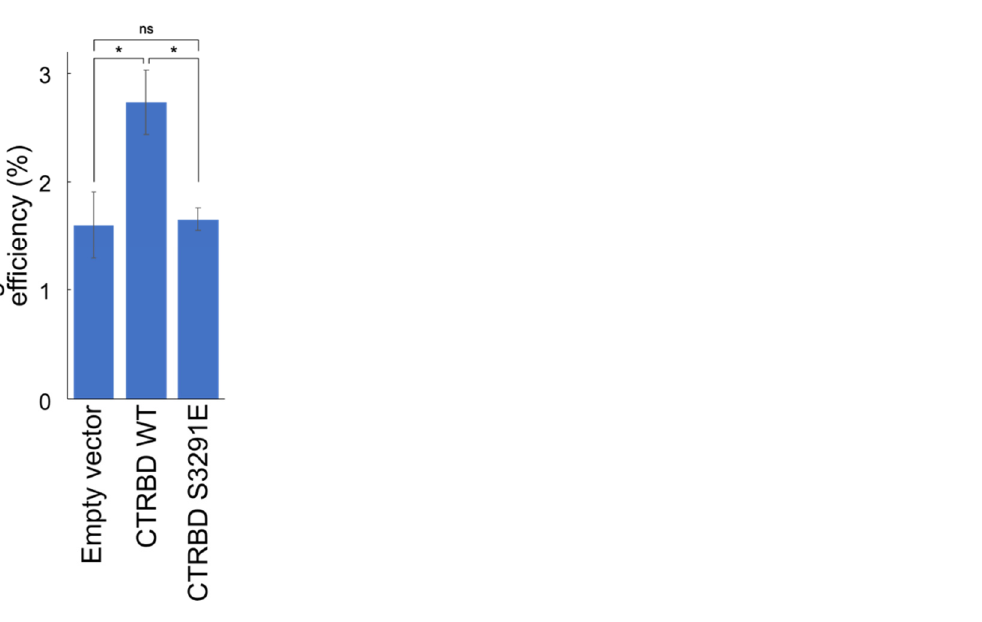
Figure 4. Expression of the CTRBD increases the homologous recombination repair efficiency. ( A ) Expression of the wild-type or S3291E-mutated CTRBD (3260–3331 aa) in HeLa cells harboring DR-GFP, a GFP-based homologous recombination efficiency-assessing construct, was determined via Western blotting by using anti-FLAG antibody. ( B ) A clonogenic survival assay of wild-type or S3291E-mutated FLAG-HA-fused BRCA2 CTRBD-expressing cells treated with mitomycin ( C ) (MMC) is shown. Results are presented as the mean at each MMC dose, and error bars indicate the standard deviation ( n = 3). Significance was examined by an F-test, followed by Student’s t- test with Holm’s correction. Asterisks indicate significant differences between empty vector-transduced HeLa cells and S3291E mutant or wild-type BRCA2 CTRBD-expressing cells (* p < 0.05, ** p < 0.01). ( C ) Homologous recombination efficiency was tested using a GFP-based assay. The transfection efficiency was normalized by the cotransfection of the DsRed monomer-expressing vector. Significance was examined by an F-test, followed by Student’s t- test with Holm’s correction. Asterisks indicate significant differences (* p < 0.05, ** p < 0.01). The error bars indicate the standard deviation ( n = 3). ns: non-significant.